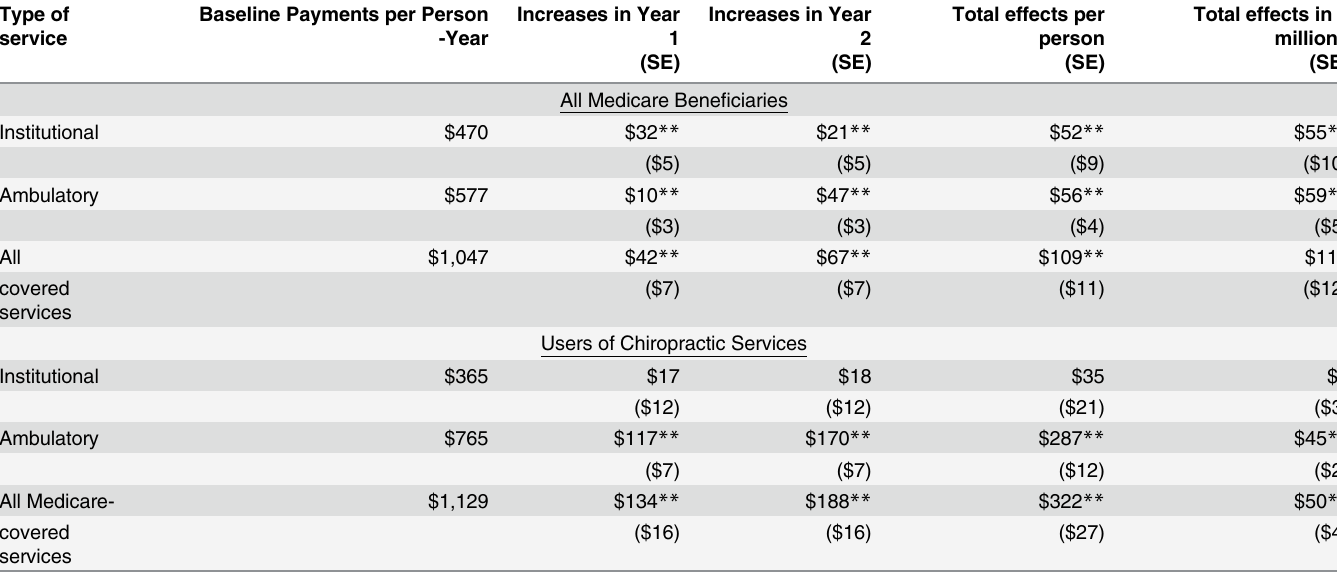
Table 2. Effects of the Demonstration on Medicare Payments for Beneficiaries with Neuromusculoskeletal (NMS) Diagnoses. Type of